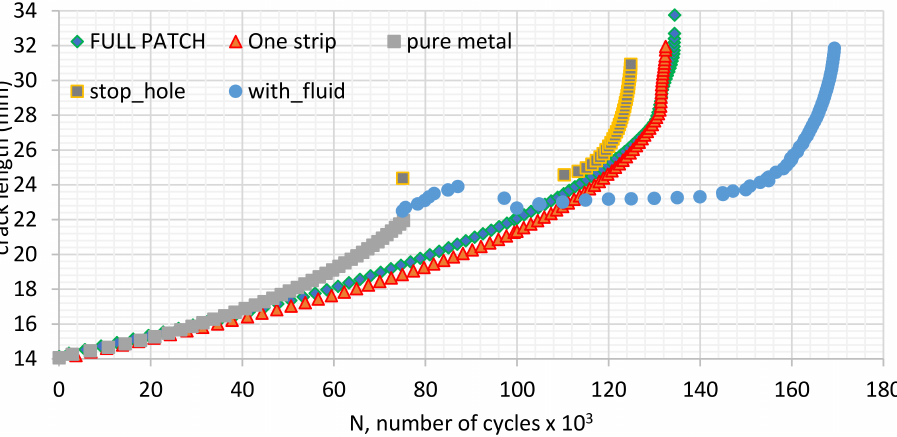
Figure 7. Fatigue crack growth curves for all tested